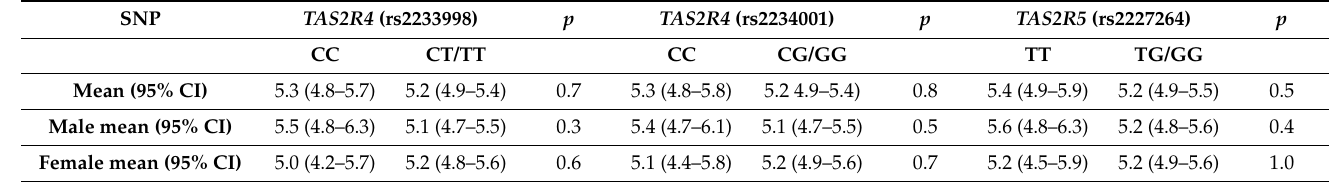
Table 5. TAS2R genotype does not significantly affect the average number of serves of high-epicatechin foods per day.